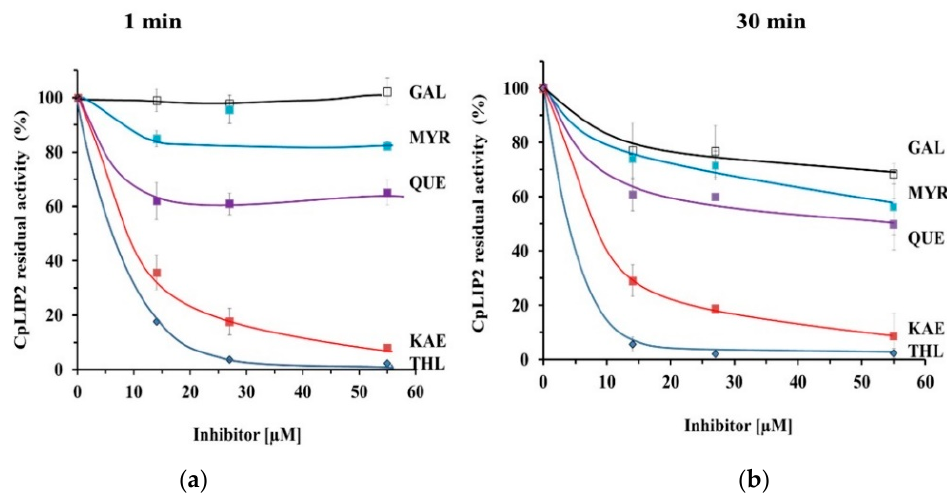
Figure 2. Inhibition of CpLIP2 hydrolytic activity by THL (positive control), and four flavonols (GAL, KAE, QUE, MYR) tested at various concentrations (14, 27.5, 55 µM equal to 25, 50, 100-fold the final concentration of CpLIP2 lipase at 0.55 µM, respectively). Each potential inhibitor was pre-incubated with CpLIP2 at 25 °C with continuous stirring in presence of ethanol 1% for 1 min ( a ) and 30 min ( b ) of pre-incubation time. Hydrolysis reactions of ethyl oleate (EO) were conducted at 30 °C for 15 min, and then measured by gas chromatography as described in the Section 4. Results are expressed as mean values ± SD, n = 6–9. THL, orlistat; GAL, galangin; KAE, kaempferol; QUE, quercetin; MYR, myricetin.